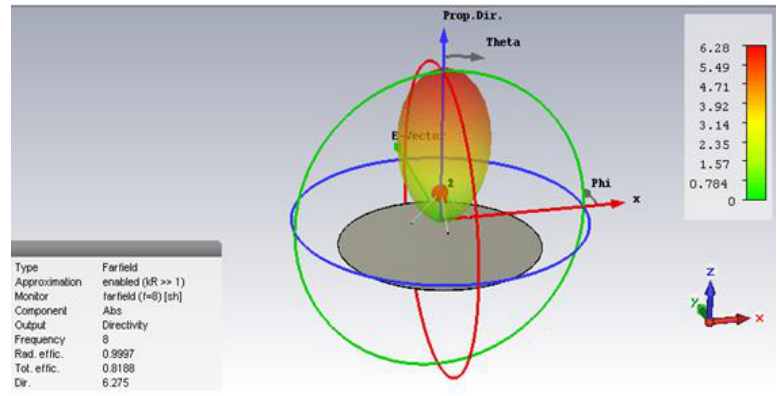
Fig. 4. Turnstile emitter